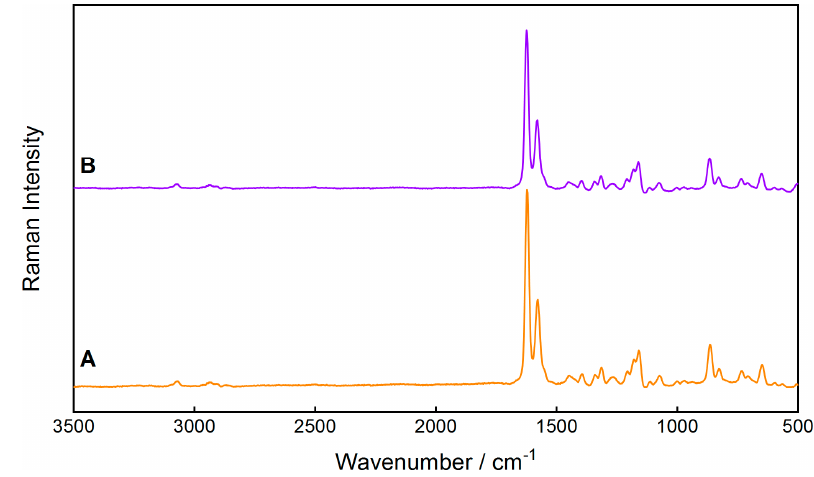
Figure 2. Comparison of the Raman spectra of ( A ) the genuine Riamet ® tablet and ( B ) the model tablet Lu100Ar100 with the nominal 100% content of the active ingredients.